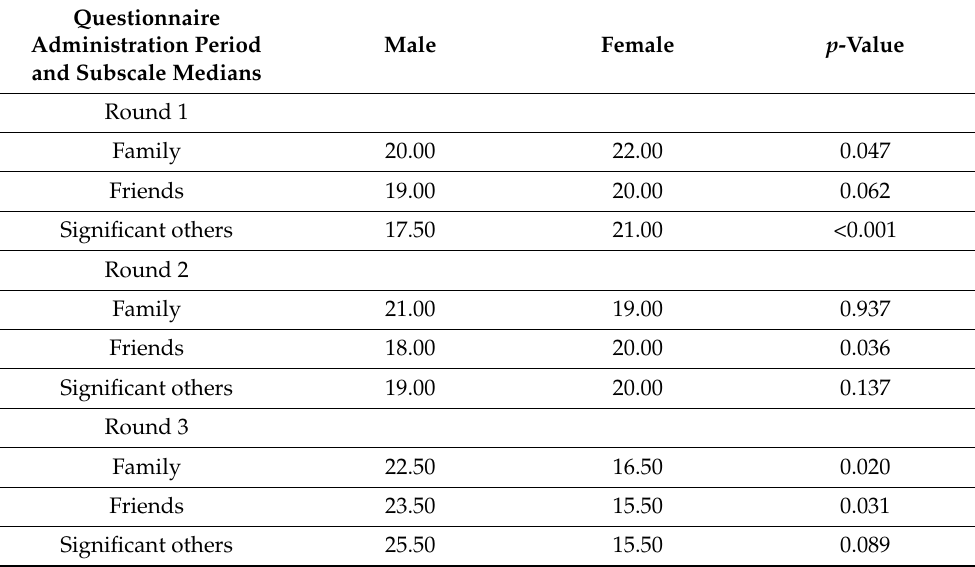
Table 3. Gender differences in perceived social support subscales among international students.